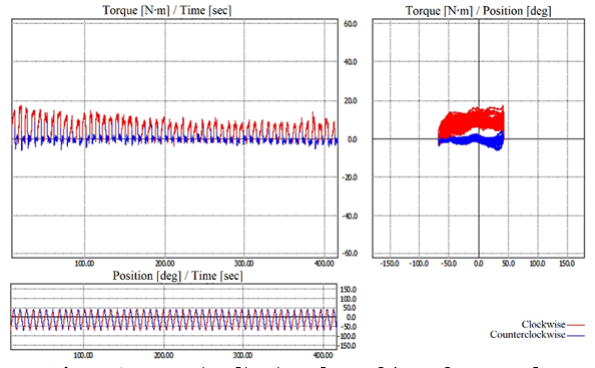
Figure 3. Data visualization plane of the software